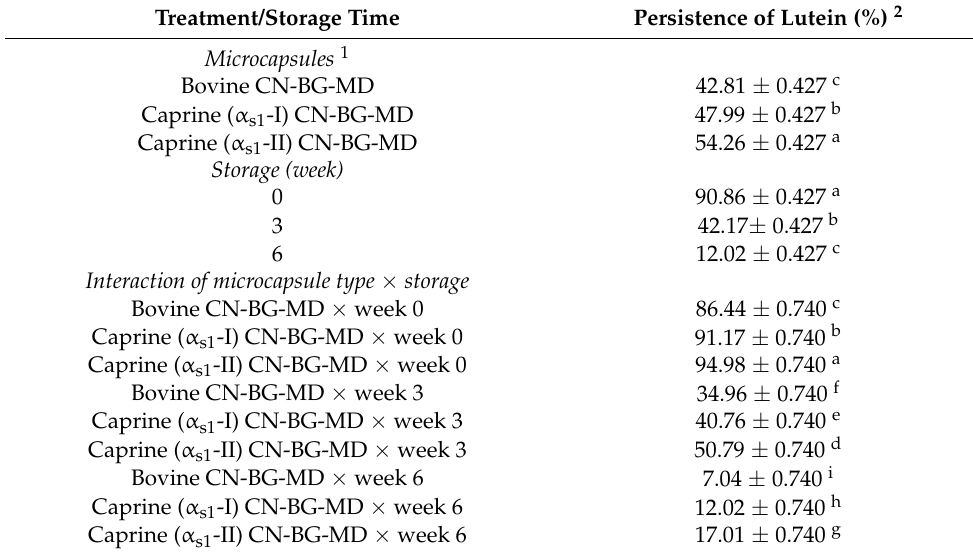
Table 7. Persistence of lutein in the lutein microcapsules during storage for 6 weeks at 40 ◦ C and 32% relative